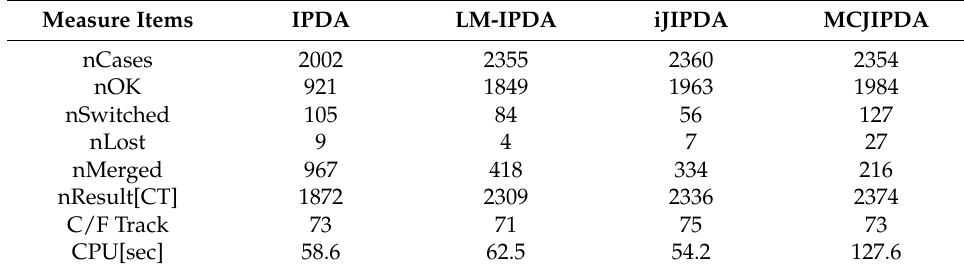
Table 6. Track retention statistics for Case